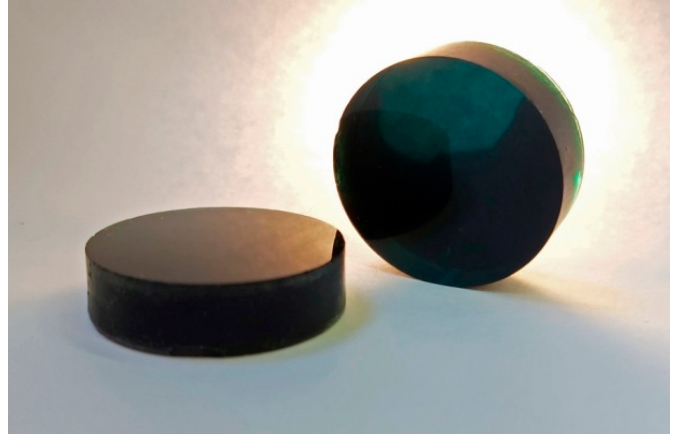
Figure 6. The optical elements made of mixed KCNSH crystals. Diameter 30 mm, height 10 mm.